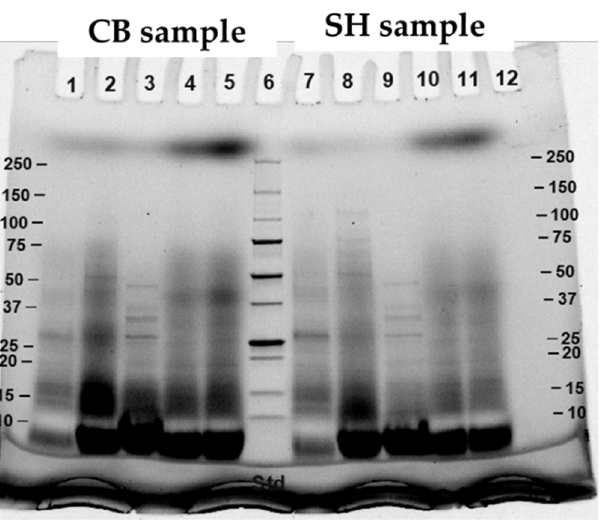
Figure 6. SDS-PAGE of commercial broiler breasts (CB) (lane 1–5) and spent commercial laying hen breasts (SH) (lane 7–11) digested by method 2 and collected at end of oral phase (lane 1 and 7), end of gastric phase (lane 2 and 8), and before (lane 3 and 9), half (lane 4 and 10), and end (lane 5 and 11) of intestinal phase. Lane 6 was protein maker.